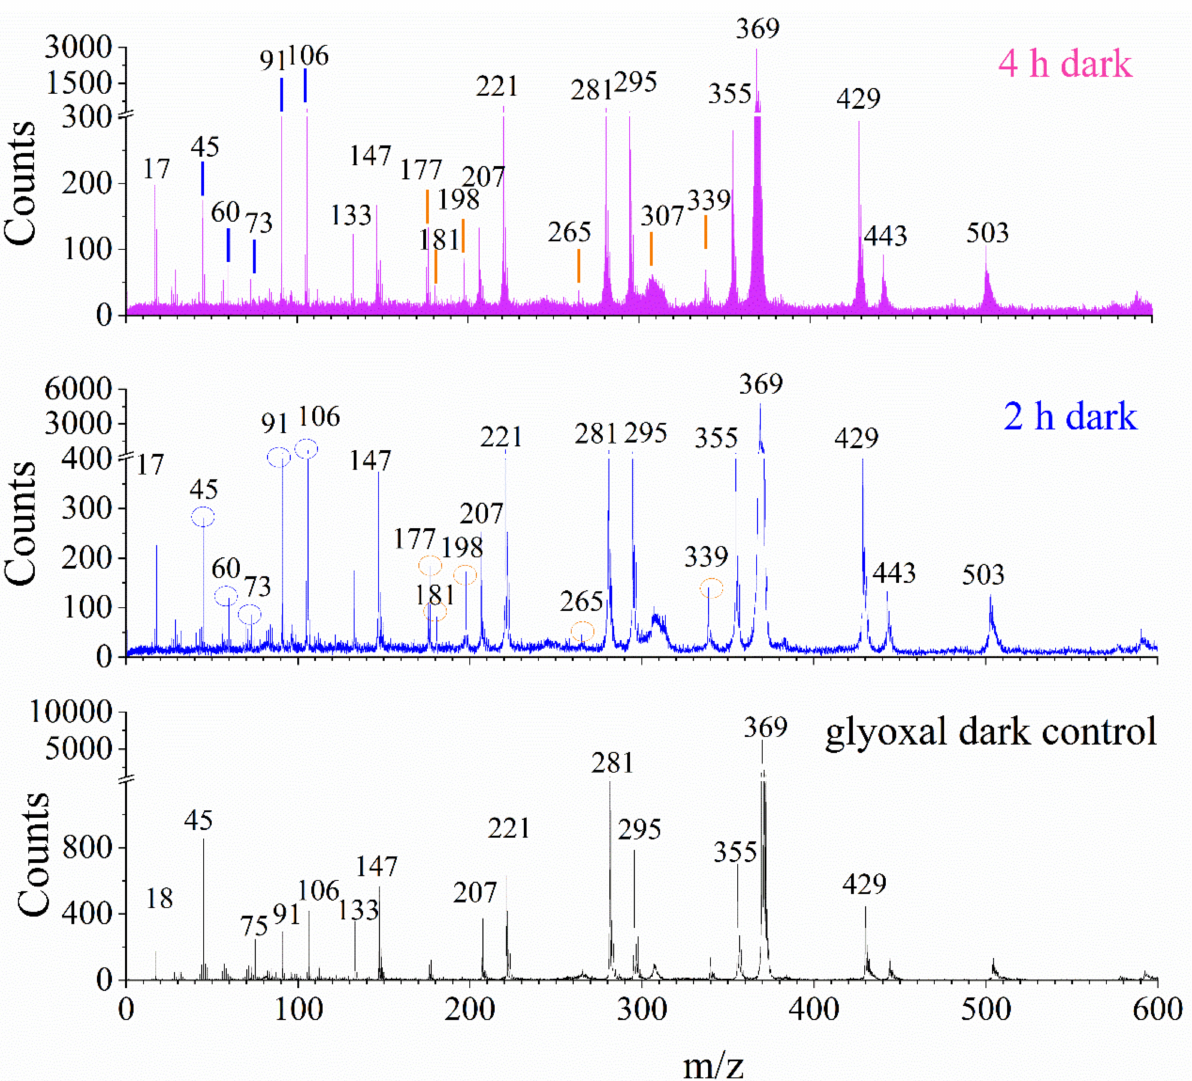
Figure 2. VUV SPI-MS spectral comparison of ( a ) 4 h and ( b ) 2 h dark reaction products of glyoxal and hydrogen peroxide solutions and ( c ) the glyoxal solution at photon energy of 12.0 eV. Blue drop lines and circles stand for reactant, intermediates, and carboxylic acids and orange drop lines and circles depict polymers and oligomers, respectively. Peaks from the glyoxal control solution and polydimethylsiloxane (PDMS) are marked without